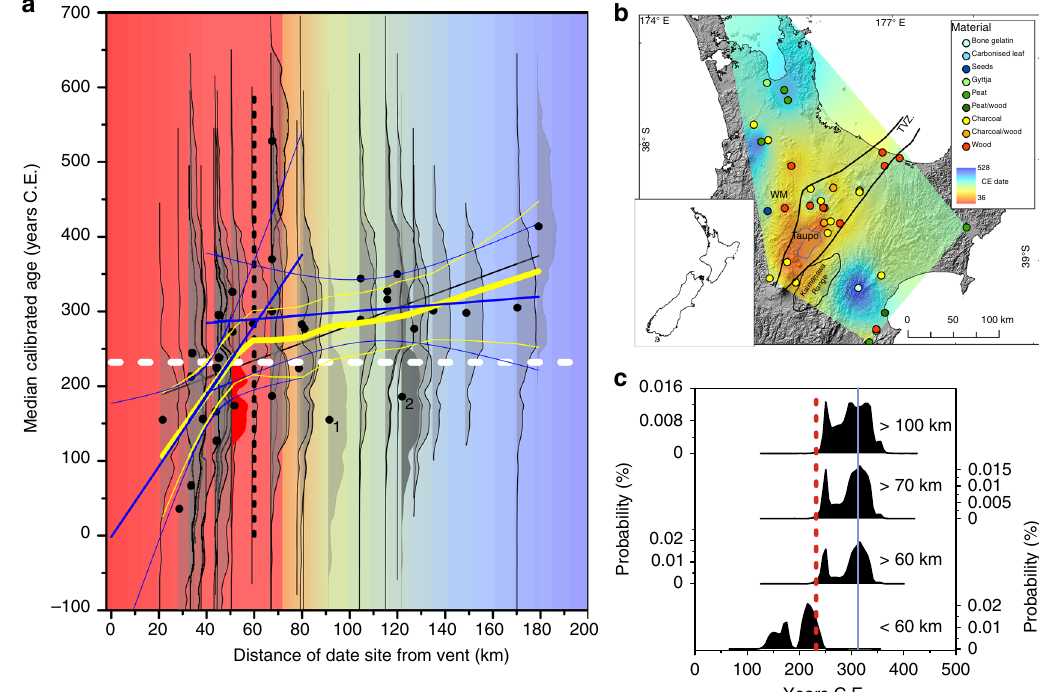
Fig. 1 Radiocarbon ages for the Taupo First Millennium eruption in relation to distance and direction from the eruptive vent. Ages are oldest nearest the vent ( “ Taupo ” ) and youngest away from the Taupo Volcanic Zone (Data in Supplementary Information Table 1). a Relationship between median calibrated age and distance from the presumed vent: yellow, local regression, 0.6 smoothing factor; blue, linear regressions for sample median ages <60 km and >60 km from vent, with 95% con fi dence limits; vertical broken line, limit of linear relationship between distance and age; white broken line, date of eruption from second wiggle match analysis; red, oldest; blue, youngest. Outer wood wiggle match age distribution in red. Note monotonic distributions of ages on samples >60 km from the vent, with 90 + % of their distributions younger than the wiggle match age. 1, NZ165, on material from Arapuni, adjacent to the Waikato River; 2, NZ1059, on peat from Lake Poukawa, probability distribution (darker shading) extends well into the calibrated range of the monotonic distant ages. b Geographic pattern of magnitude of median calibrated radiocarbon ages: red, oldest; blue, youngest. Legend shows age gradient and dated materials. c Summed probability distributions of calibrated radiocarbon ages for the Taupo eruption, for dates other than the two wiggle match series, for pooled samples at different distances from the eruption vent. Red broken line, second wiggle match date for eruption; blue line, highest probability